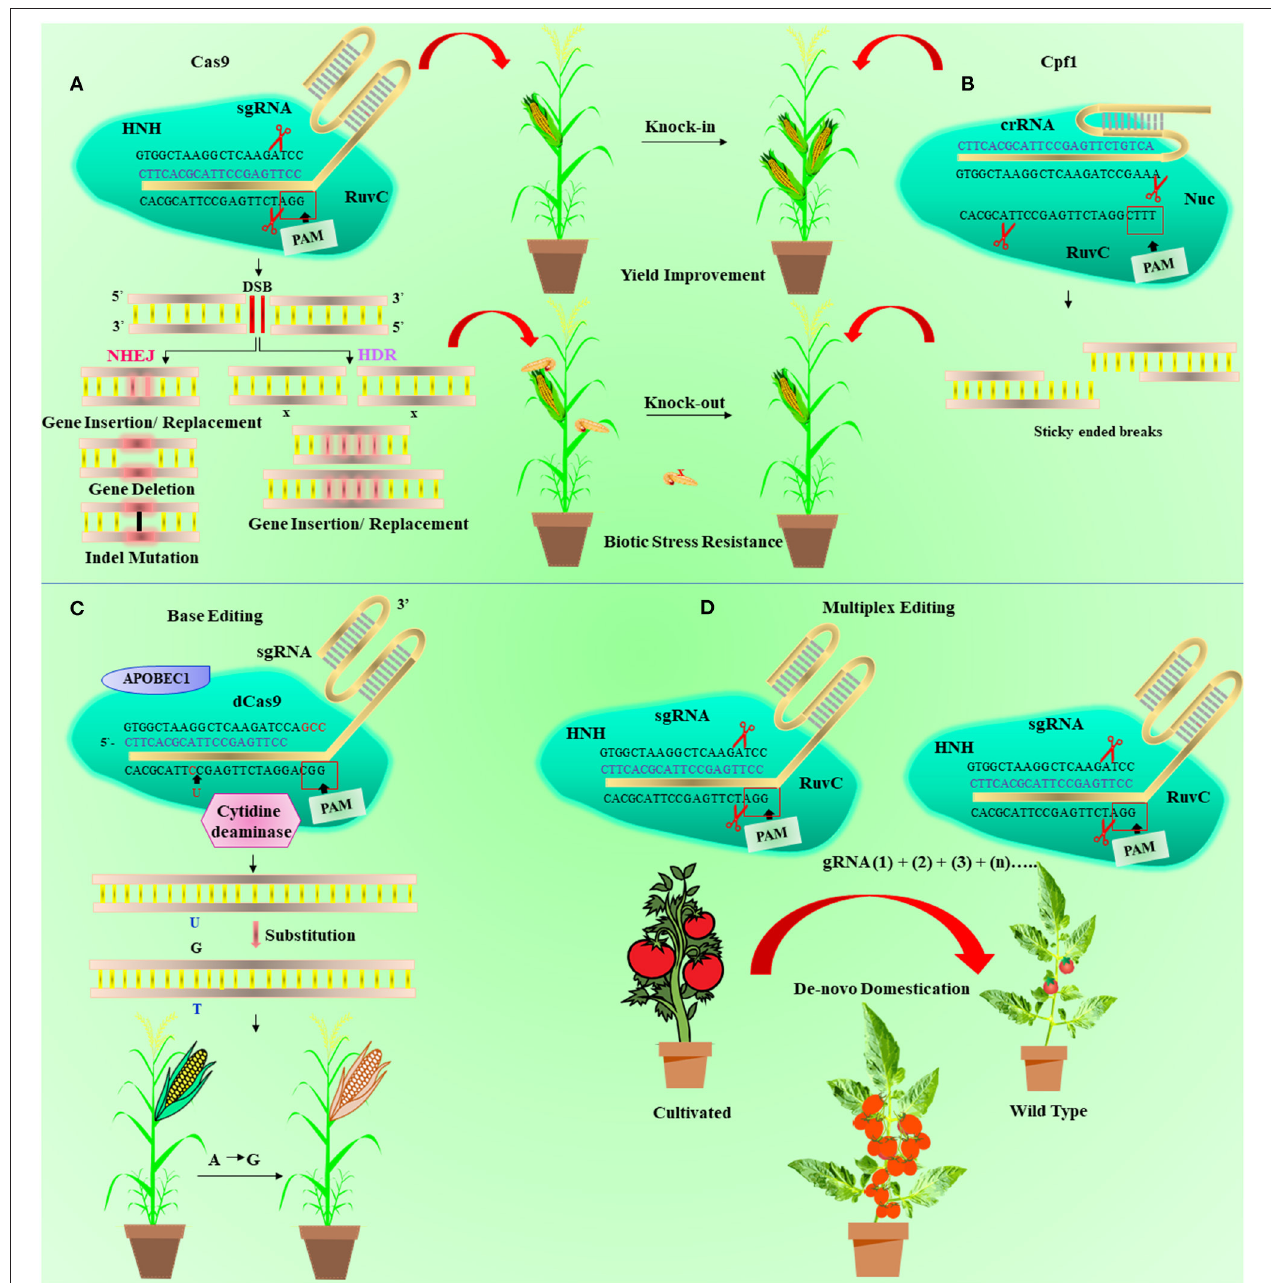
FIGURE 5 | Diagrammatic illustration of the base editing, clustered regularly interspaced short palindromic repeat/CRISPR-associated 9 (CRISPR/Cas9) and Cpf1 mechanism, and de novo domestication. (A) In the CRISPR/Cas9 mechanism, Cas9 protein is guided and activated with the help of CRISPR RNA (crRNA) and trans-activating CRISPR RNA (tracrRNA), respectively, to produce double-standard breaks (DSBs) in DNA. The single-guide RNA (sgRNA) (blue) is developed with the grouping of tracrRNA and crRNA and identifies the 20-nucleotide (orange) target sequence. This makes a complex of Cas9-sgRNA, which moves along the target site and cuts double-standard DNA 3 bases upstream of protospacer adjacent motif (PAM) through HNH and RuvC domains. The DSBs are reconstructed via nonhomologous end-joining (NHEJ) or homology-directed repair (HDR) pathway. (B) Shows the Cpf1 mechanism that recognize the 24-nucleotide target sequence (blue) of crRNA and cleaves five nucleotides opposite to T-rich (TTTN) spacer at 5 ′ end. (C) Representing the base editing in which dead Cas9 (dCas9) is associated with cytidine deaminase (brown). It is directed by sgRNA (blue) for base substitute at target sequence (orange) distal to PAM site at 3’ end. (D) depicted the de novo domestication process in wild plant using multiplex genome editing. Multiple guide RNA (gRNA) can be used to edit more than one gene simutanelously linked to some agronomic traits.